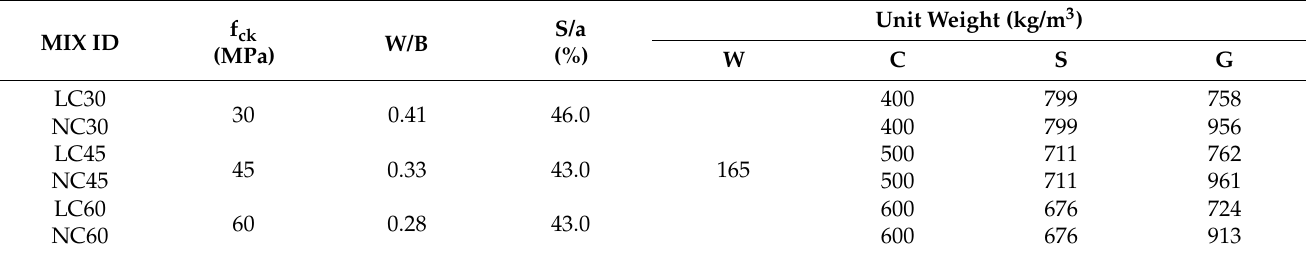
Table 5. Mix proportions of the NC and LC.